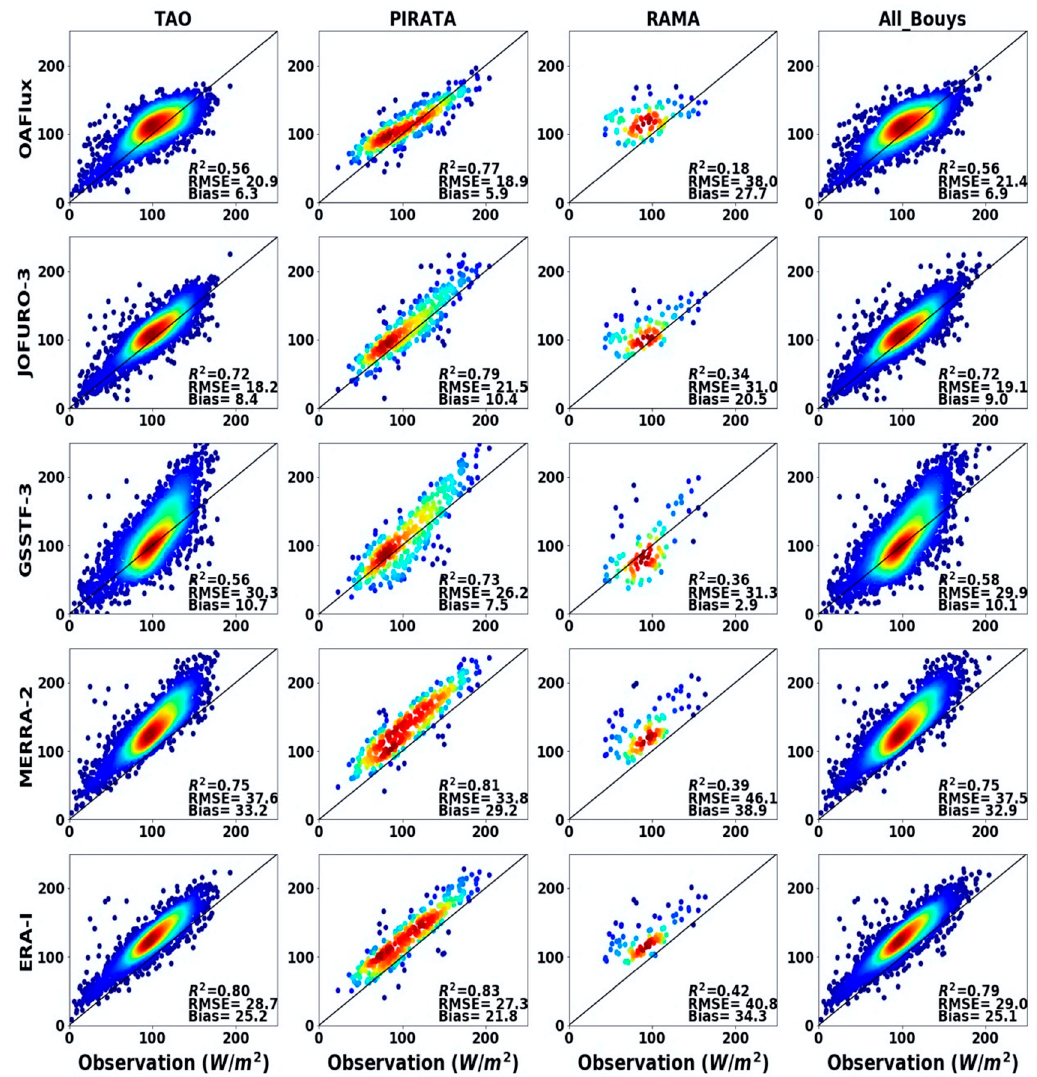
Figure 3. Validation of five products against buoy observations from 115 sites during the period from 2003 to 2007 (unit W m − 2 ).